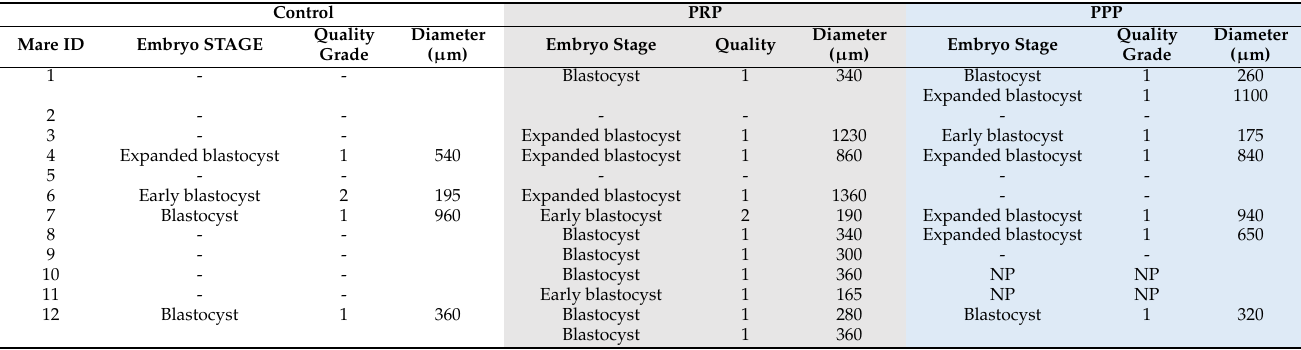
Grade 1 embryo with a spherical shape, uniform size of blastomeres, color, and texture, with no visible abnormalities. Grade 2 embryo with slight irregularities in shape, size of blastomeres, color or texture, and can present some extruded blastomeres. Grade 3 embryo can have a large percentage of extruded blastomeres, partial collapse of blastocele, or moderate shrinkage of trophoblast from zona pellucida. Grade 4 degenerated embryo with variable advanced stages irregularities. [28]. NP, not